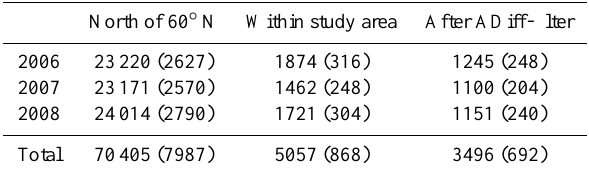
Table 1. Number of detections